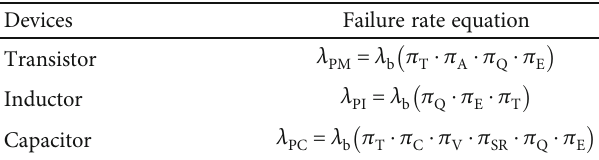
Table 1: Component stress model.